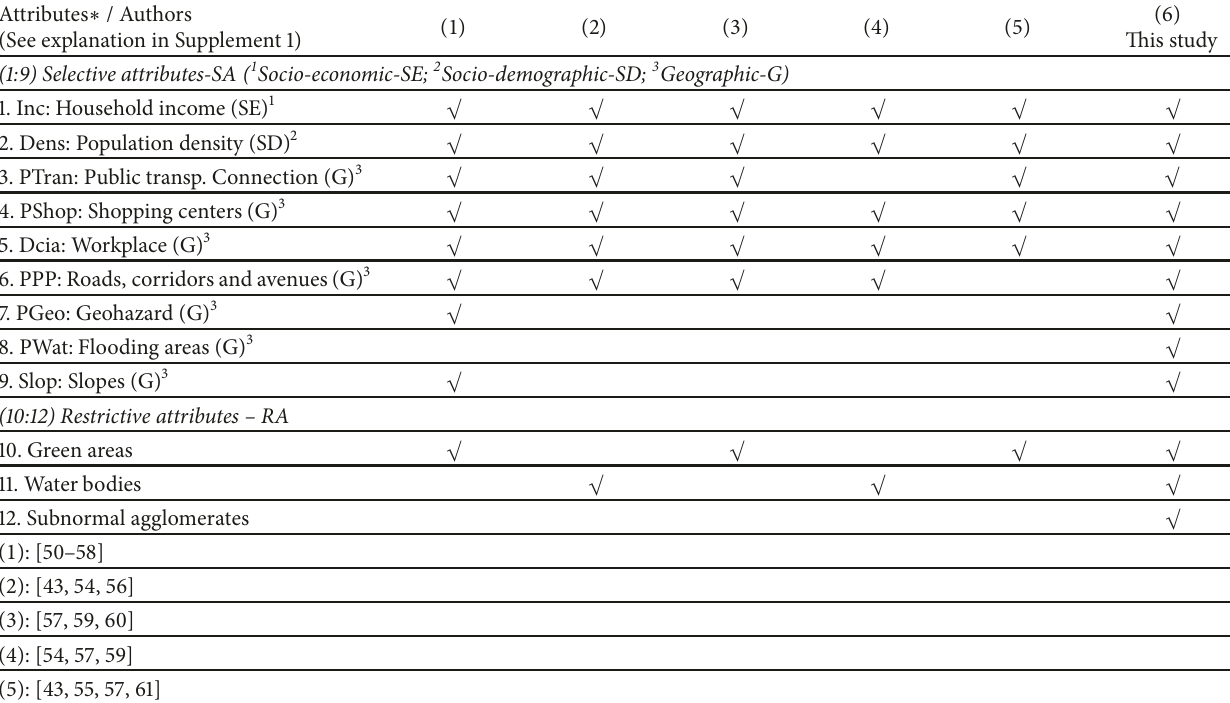
Table 1: Attributes used in similar studies ( √ –